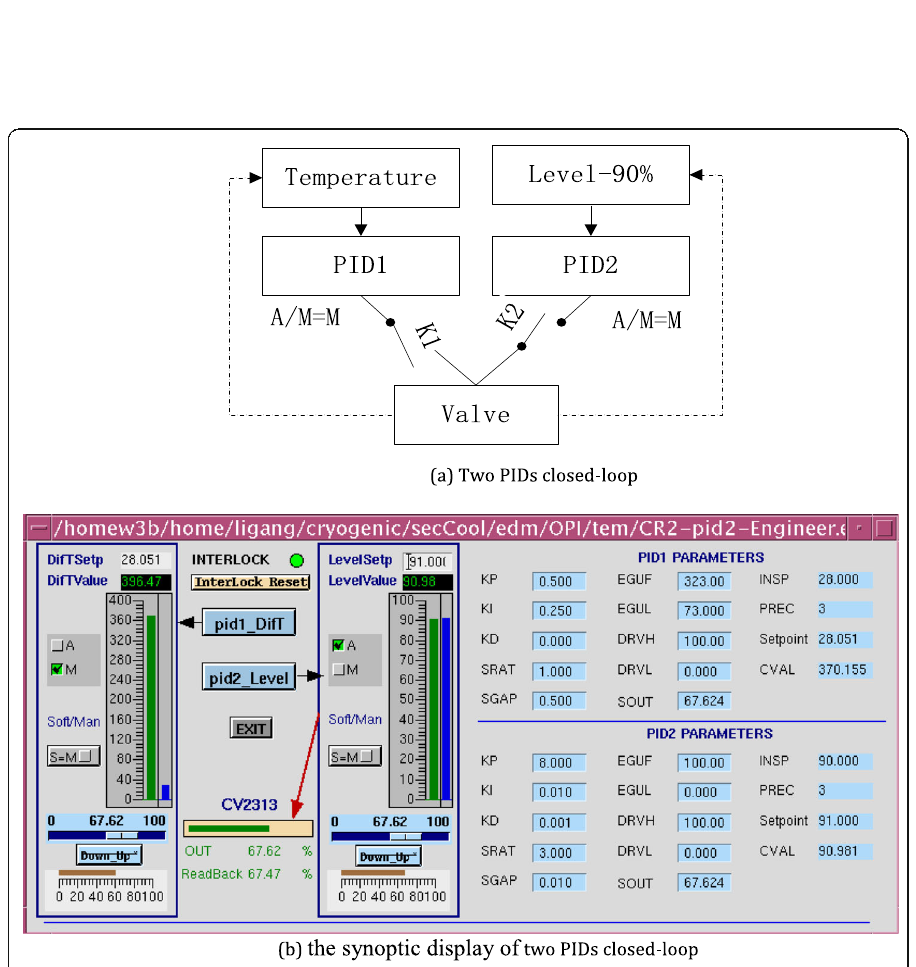
Fig. 10 One output and two PIDs